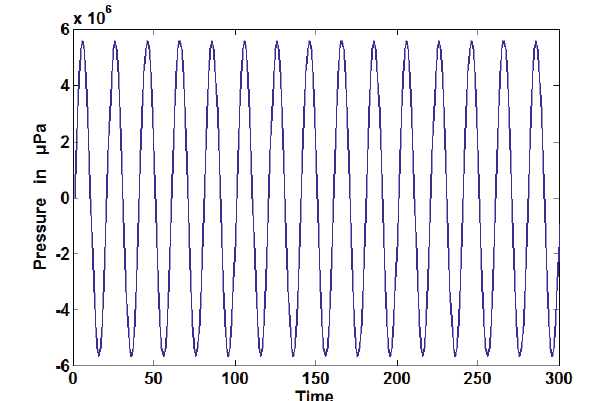
Figure 1. Input signal.